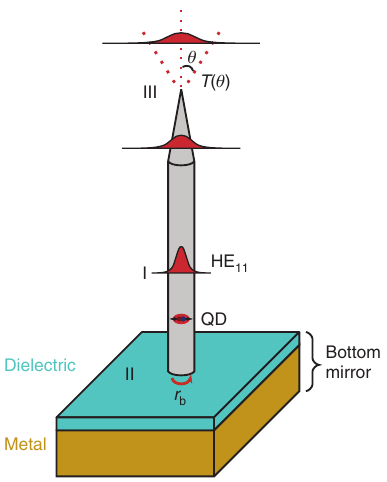
Figure 3: Schematic nanowire nanoantenna SPS